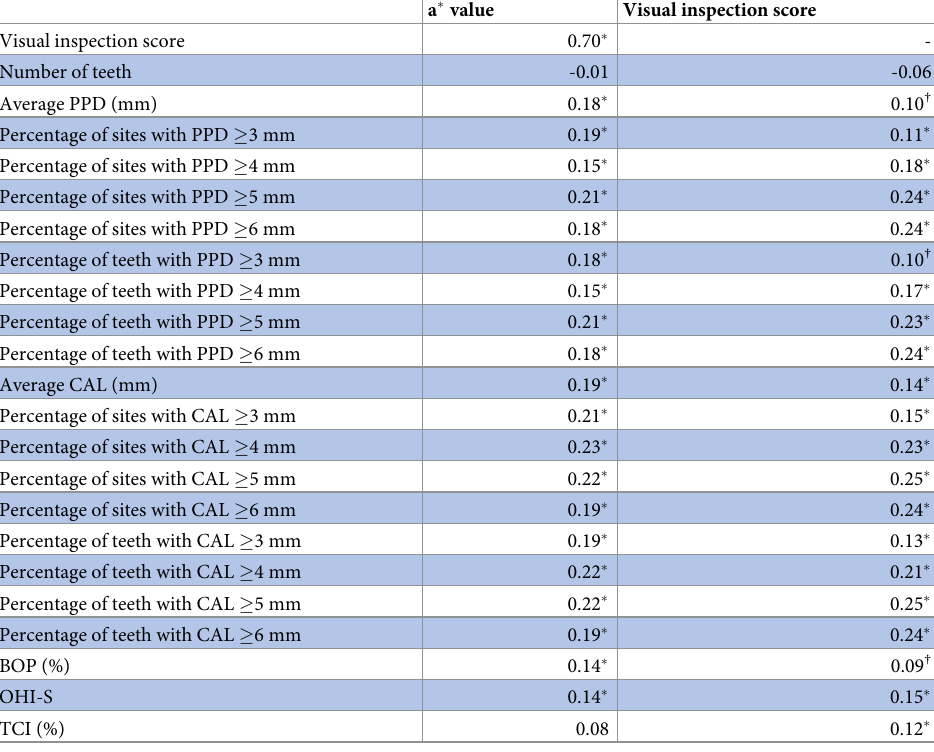
Table 2. Correlations among the a � value, visual inspection score, and oral health status